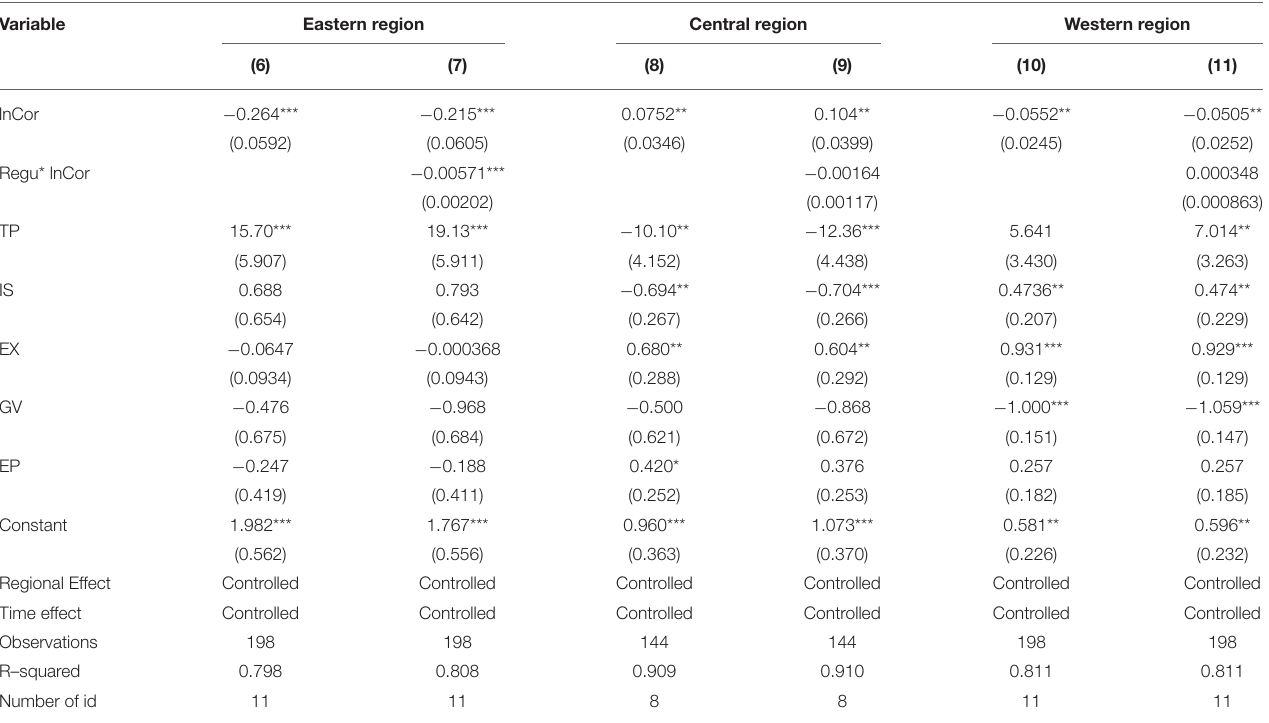
TABLE 7 | Regional regression results.